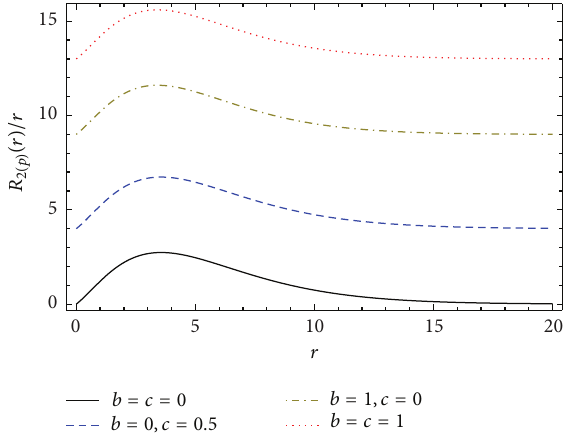
Figure 7: When 𝜆 = 500 , plot of wave functions of 2𝑝 state for different cases of 𝑏 and 𝑐 screening parameters (in arbitrary units).